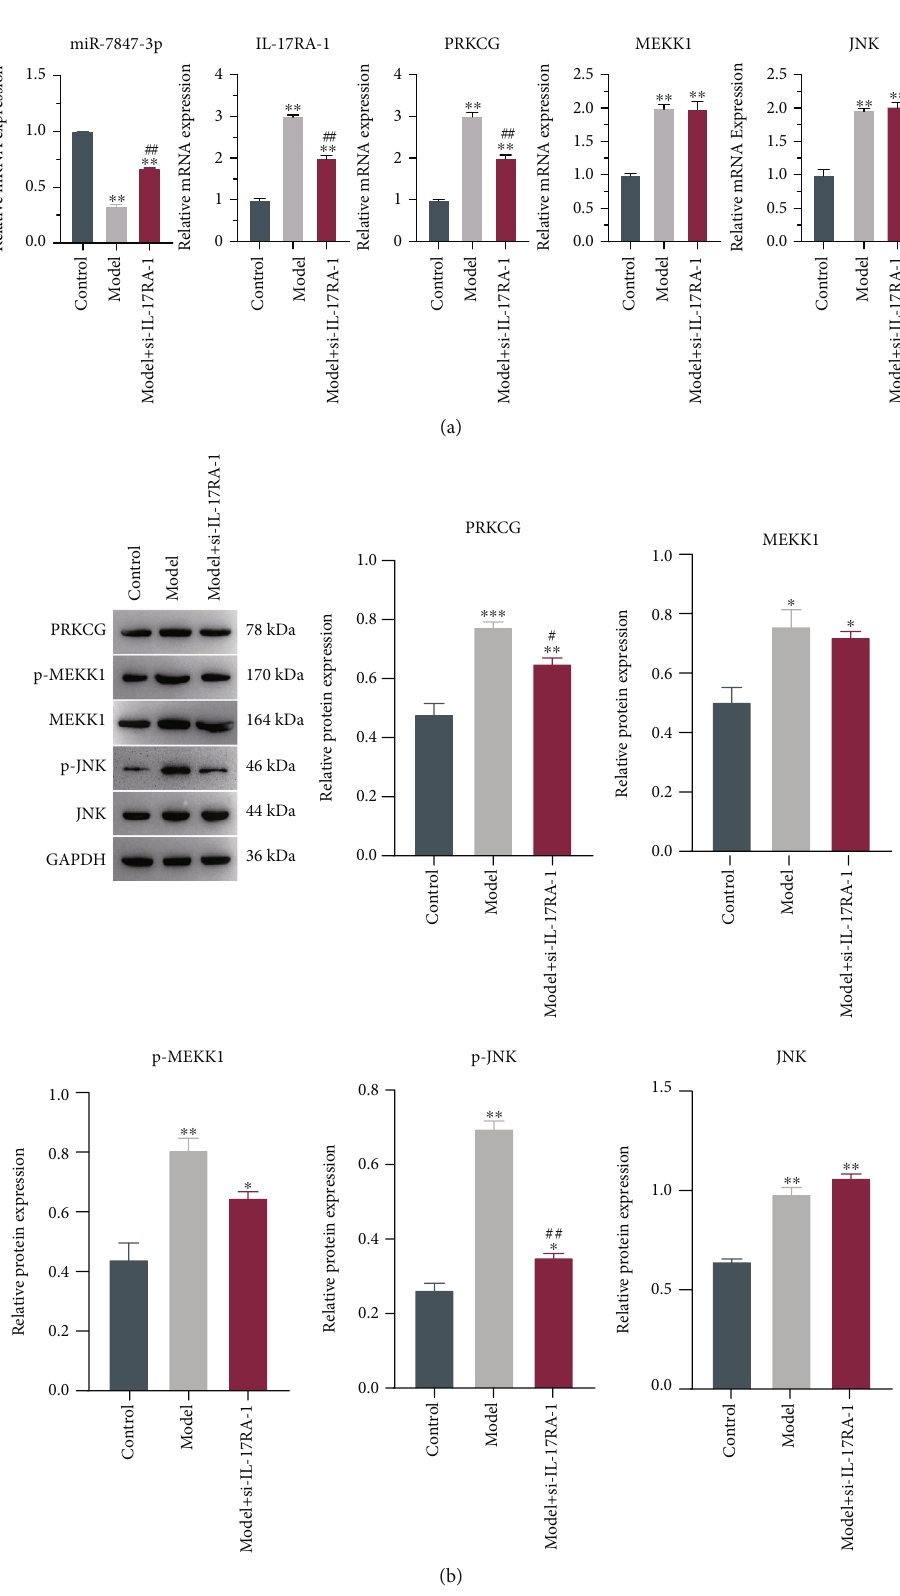
Figure 8: The e ff ect of si-IL-17RA-1 on the expression of miR-7847-3p, PRKCG, MEKK1, JNK mRNA, and proteins. (a) qRT-PCR detection of mRNA expression of miR-7847-3p, IL-17RA-1, PRKCG, MEKK1, and JNK. (b) Western blot detection of PRKCG, MEKK1, JNK, p-MEKK1, and p-JNK